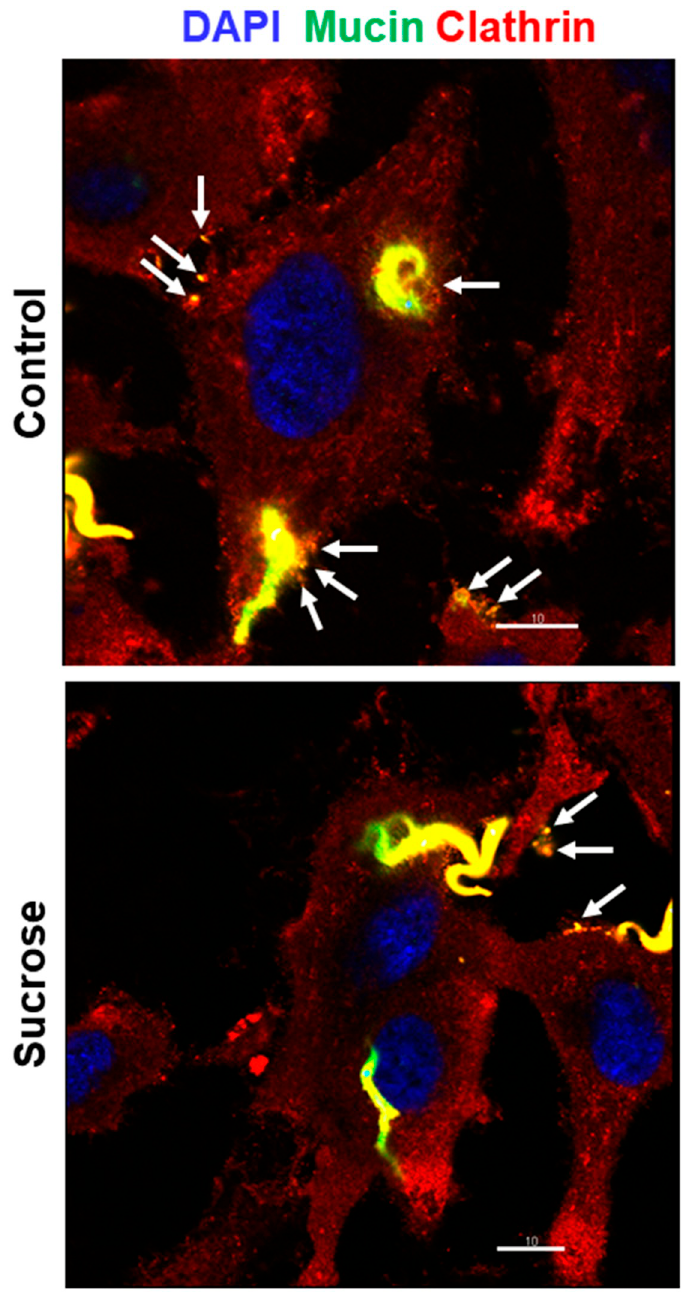
Fig 8. Reduced gp35/50 mucin co-localization with clathrin in sucrose-treated cells. Untreated and sucrose-treated HeLa cells were incubated for 30 min with MT and processed for immunofluorescence microscopy, using anti-clathrin antibody and mAb 10D8. Note the clathrin-positive gp35/50 mucins (arrows) in the parasite vicinity or attached to cell membrane. Scale bar = 10 μ m. https://doi.org/10.1371/journal.pntd.0010788.g008 checked. HeLa cells were incubated for 1 h in absence or in the presence of 40 μ g/ml r-gp82 or GST, used as control for the recombinant protein fused to GST, and the number of internal- ized parasites was quantified. MT invasion was significantly inhibited by r-gp82 but not by GST (Fig 9C). Presumably the inhibitory effect of r-gp82 is due to its ability to induce F-actin